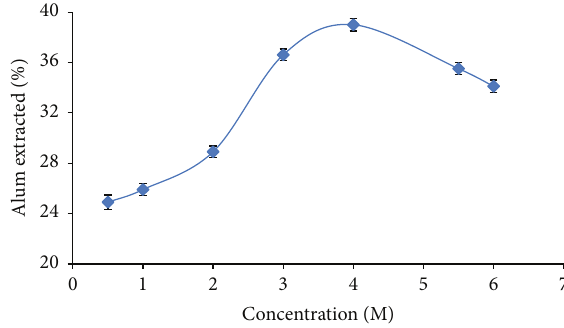
Figure 9: Effect of acid concentration on the extraction of alu- minum sulphate (leaching time: 1.5h; leaching temperature: 100 ∘ C; particle size: 100 𝜇 m; error bar = ± SD; and 𝑛 = 3 ).